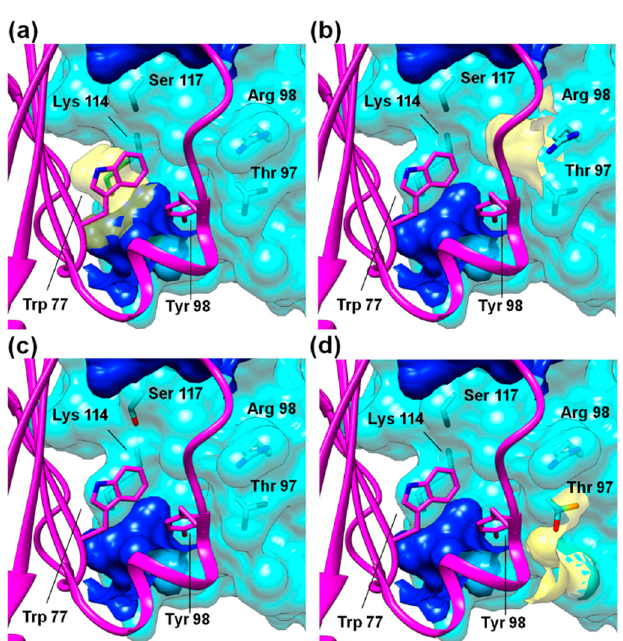
Figure A1. Computed solvent-accessible surfaces between molecules in the E. coli heterodimer. Solvent-accessible surfaces (blue) between RsfS (magenta cartoon) and uL14 (cyan surface). Additional solvent-accessible surfaces (yellow) that open in E. coli uL14 mutants: ( a ) T97A, ( b ) R98A, ( c ) K114A and ( d ) S117A .